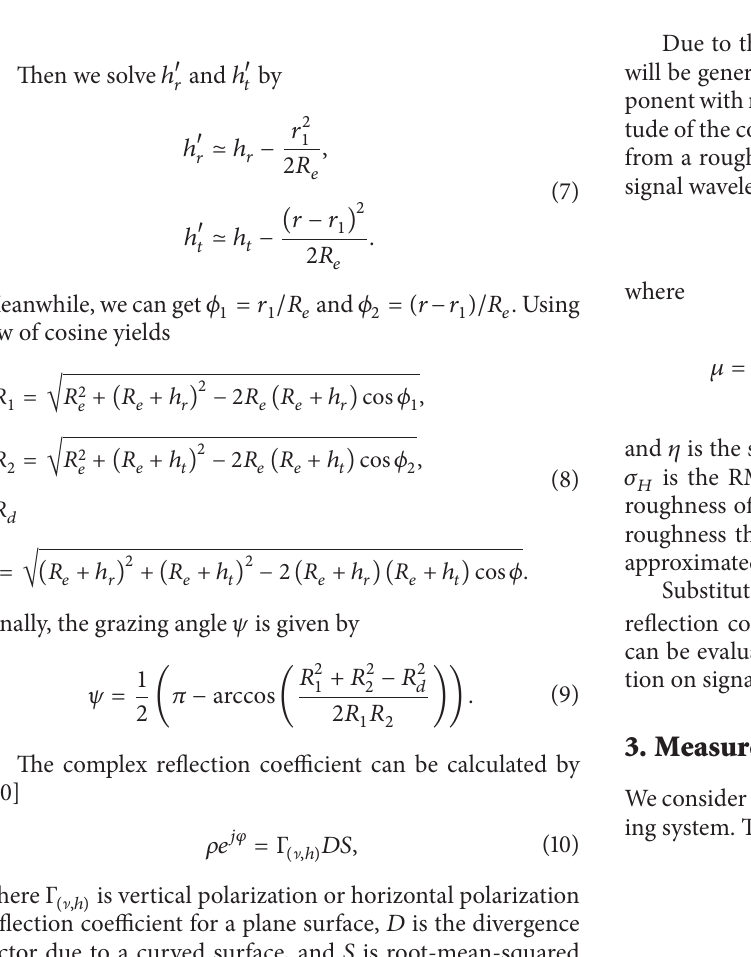
Figure 2: Modified multipath propagation